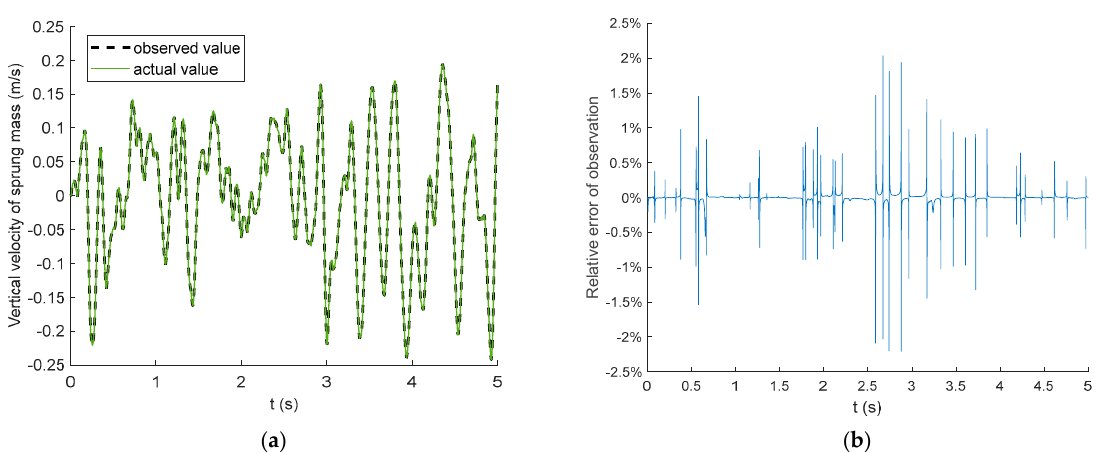
Figure 7. Observed results of vertical velocity of the sprung mass. ( a ) Comparison of observed and actual values. ( b ) Relative error between observed and actual values.